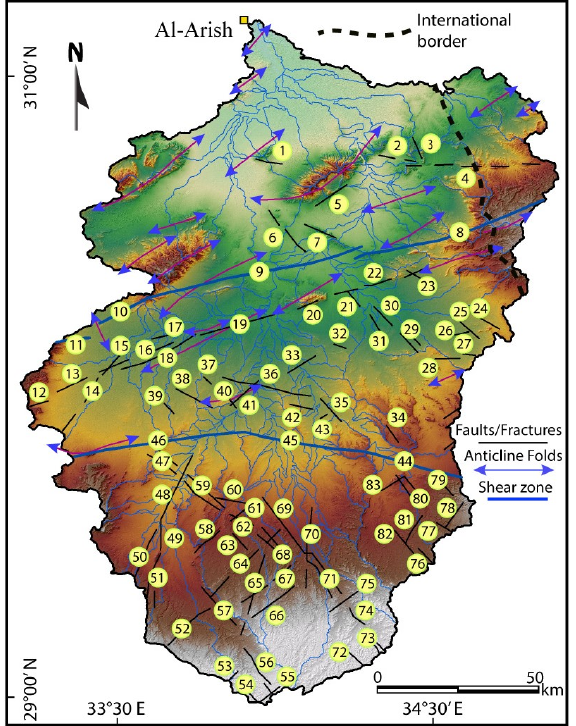
Figure 8. Map of mountain front sinuosity (Smf) locations and 83 mountain front segments for the Smf index.